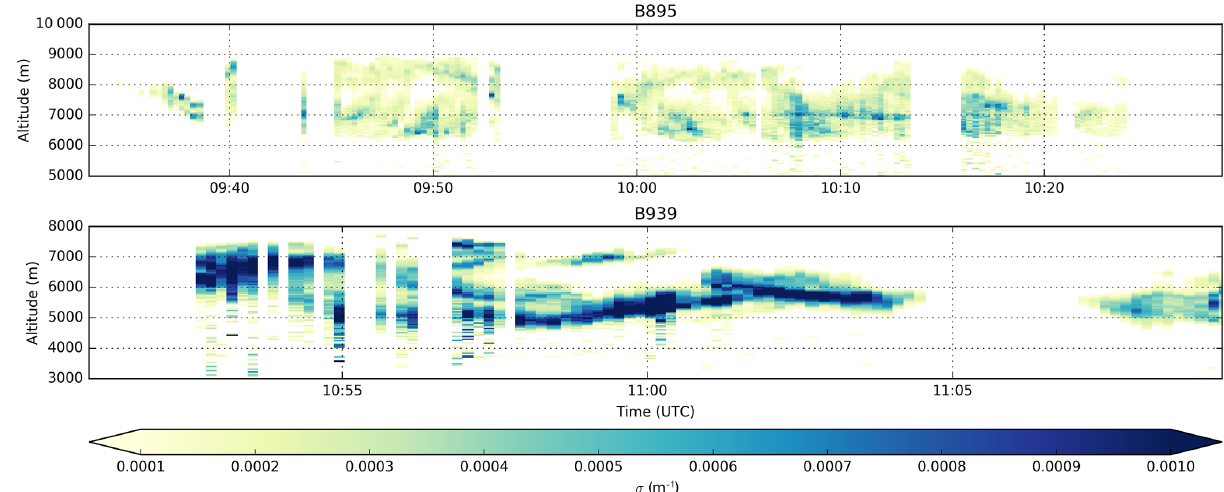
Figure 2. Lidar particle extinction profiles. Missing data correspond to aircraft turns or times when the lidar did not penetrate the full cloud